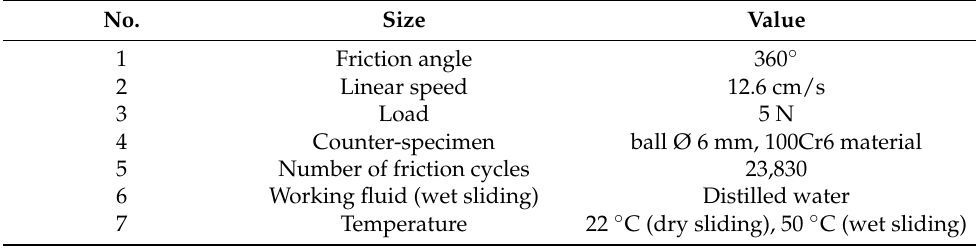
Table 3. Roughness values of tested polymers.